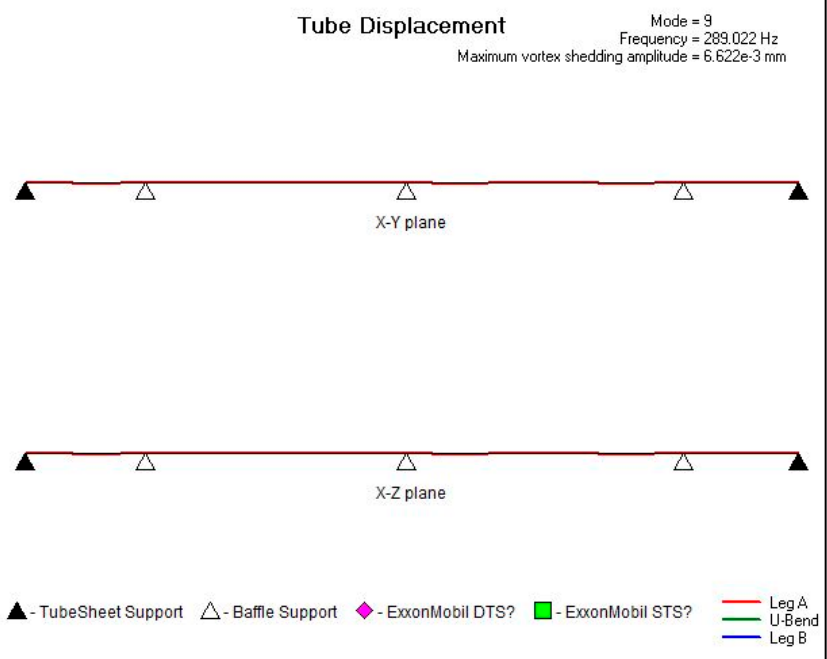
Figure 12. Tube displacement profiles of modes 9 and 10, 289.02 Hz.